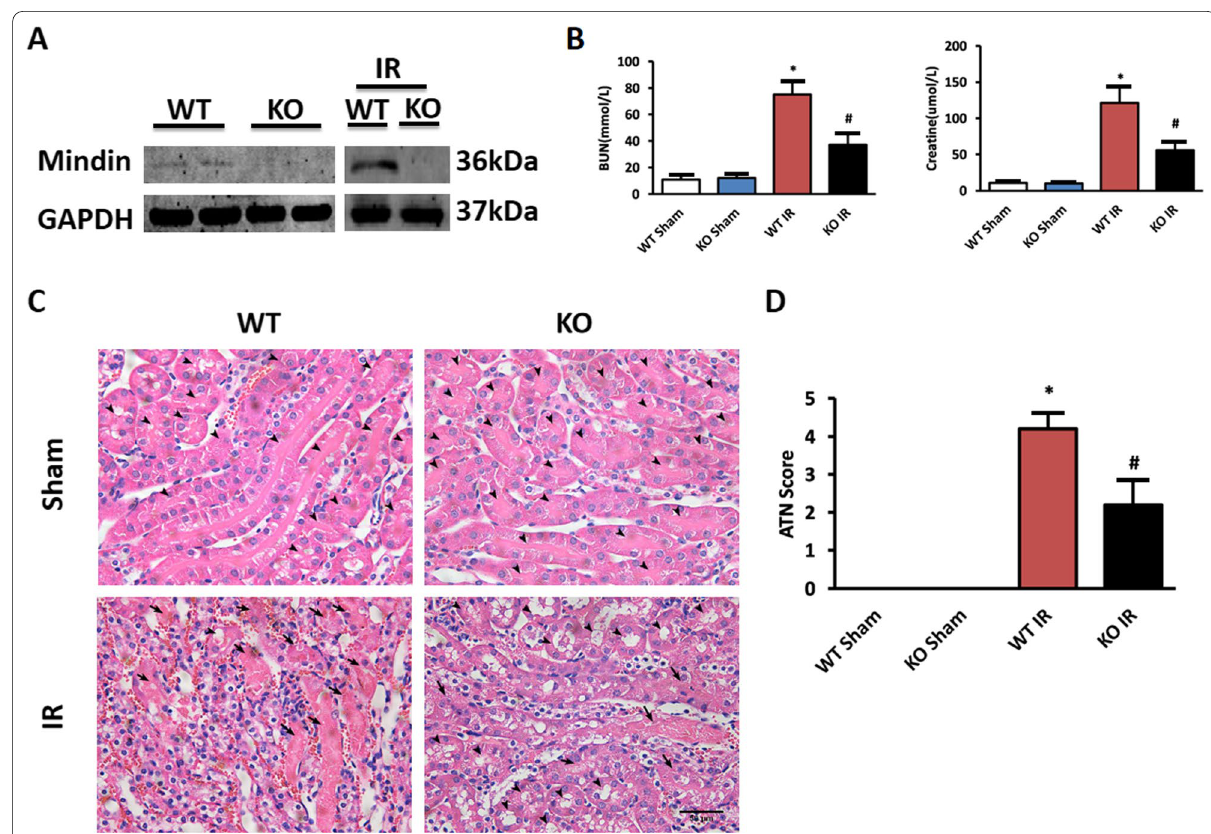
Fig. 2 Mindin deficiency attenuated renal IR injury. A Mindin protein expression in kidneys from WT and Mindin KO mice with and without IR. B Levels of BUN and Cre after renal IR injury in WT and mindin KO mice. *P < 0.05 versus WT Sham or KO Sham. # P < 0.05 versus WT IR. C Representative photomicrographs showing HE staining in WT and mindin KO mice with or without renal IR injury (magnification 400 graded using the acute tubular necrosis (ATN) score. *P < 0.05 versus WT Sham or KO Sham. # P < 0.05 versus WT IR